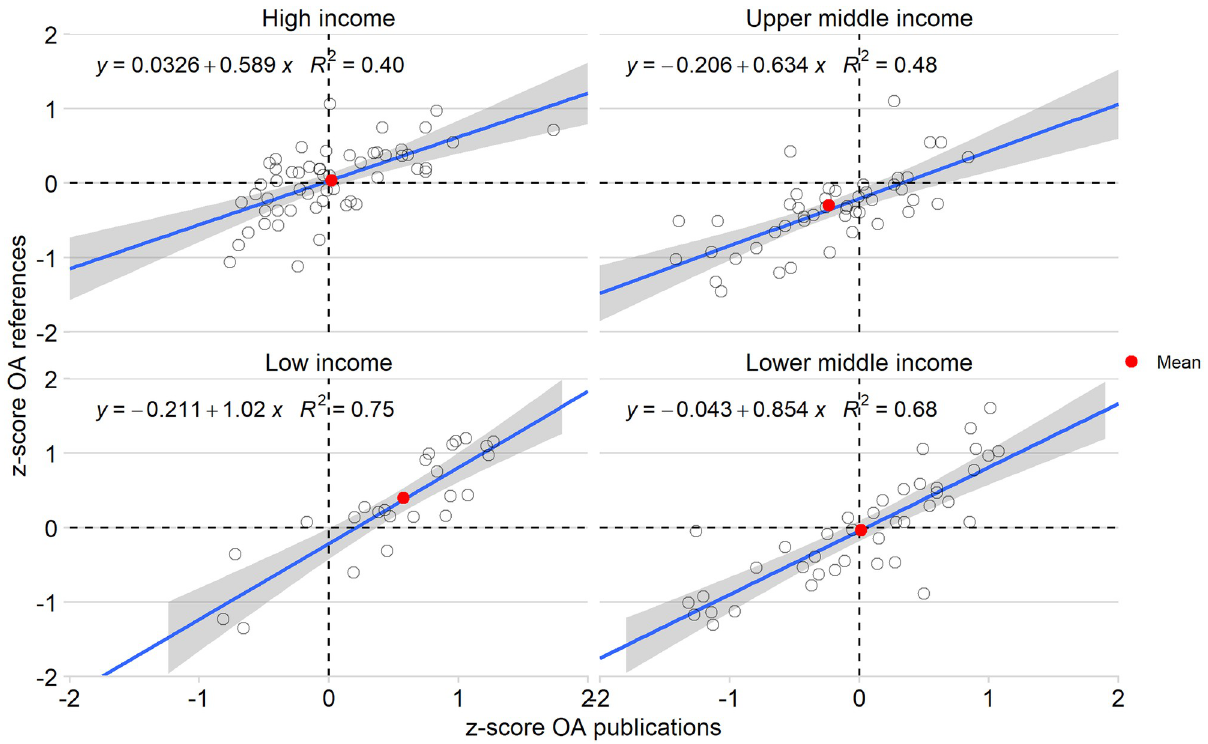
Fig 4. OA publication vs. references per country income (red dots; average for all the countries of the same income category).